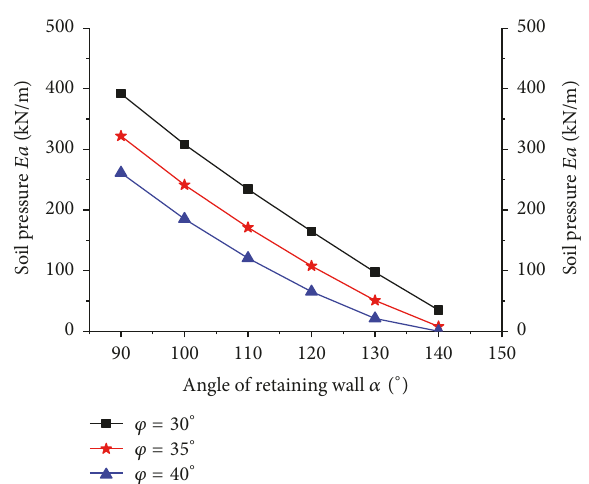
Figure 5: The curve of the soil pressure changing with angle.